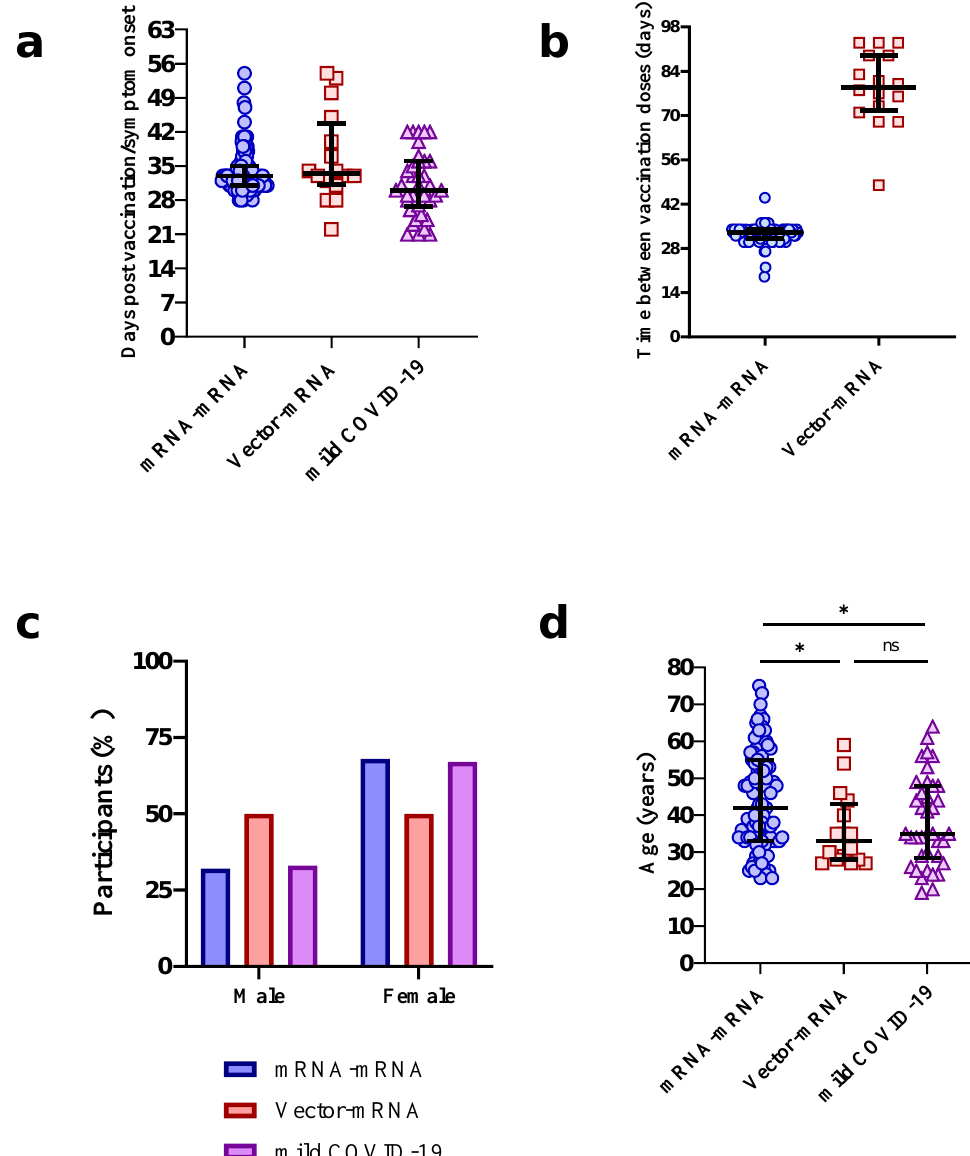
Figure 1. Participant characteristics. Distribution of days post booster COVID-19 vaccination or post symptom onset after SARS-CoV-2 infection ( a ), time between prime and boost vaccination doses ( b ), sex ( c ) and age ( d ) in mRNA–mRNA (blue, n = 98), vector–mRNA (red, n = 16) and mild COVID-19 (purple, n = 38) groups. The mRNA–mRNA group was found to be significantly older than the vector–mRNA and mild COVID-19 groups (* p = 0.018 and * p = 0.021, respectively, Mann–Whitney U tests). ns = not significant. The bold lines represent the median and interquartile